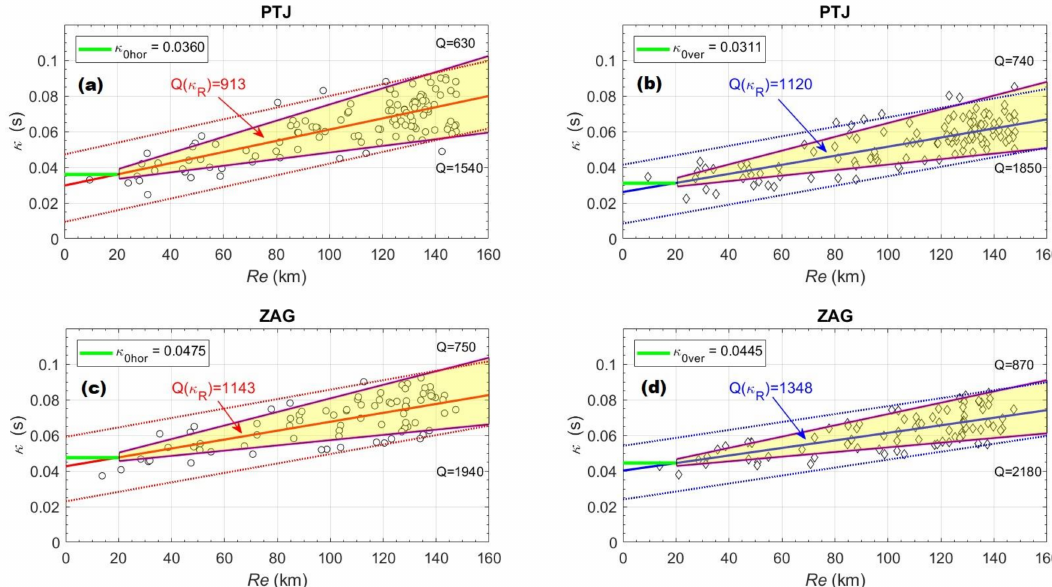
Figure 6. Comparison of results from di ff erent methods to estimate κ 0 . PTJ station: ( a ) horizontal model, ( b ) vertical model. ZAG station: ( c ) horizontal model, ( d ) vertical model. Thick green line indicates constrained κ 0 value at shorter distances. Zero-distance regression line indicate the κ 0 value estimated from Figure 5. Yellow range shows Q models for di ff erent slopes applied within ± 2 standard deviations (dotted lines) at larger epicentral distances for a fixed κ 0 value.